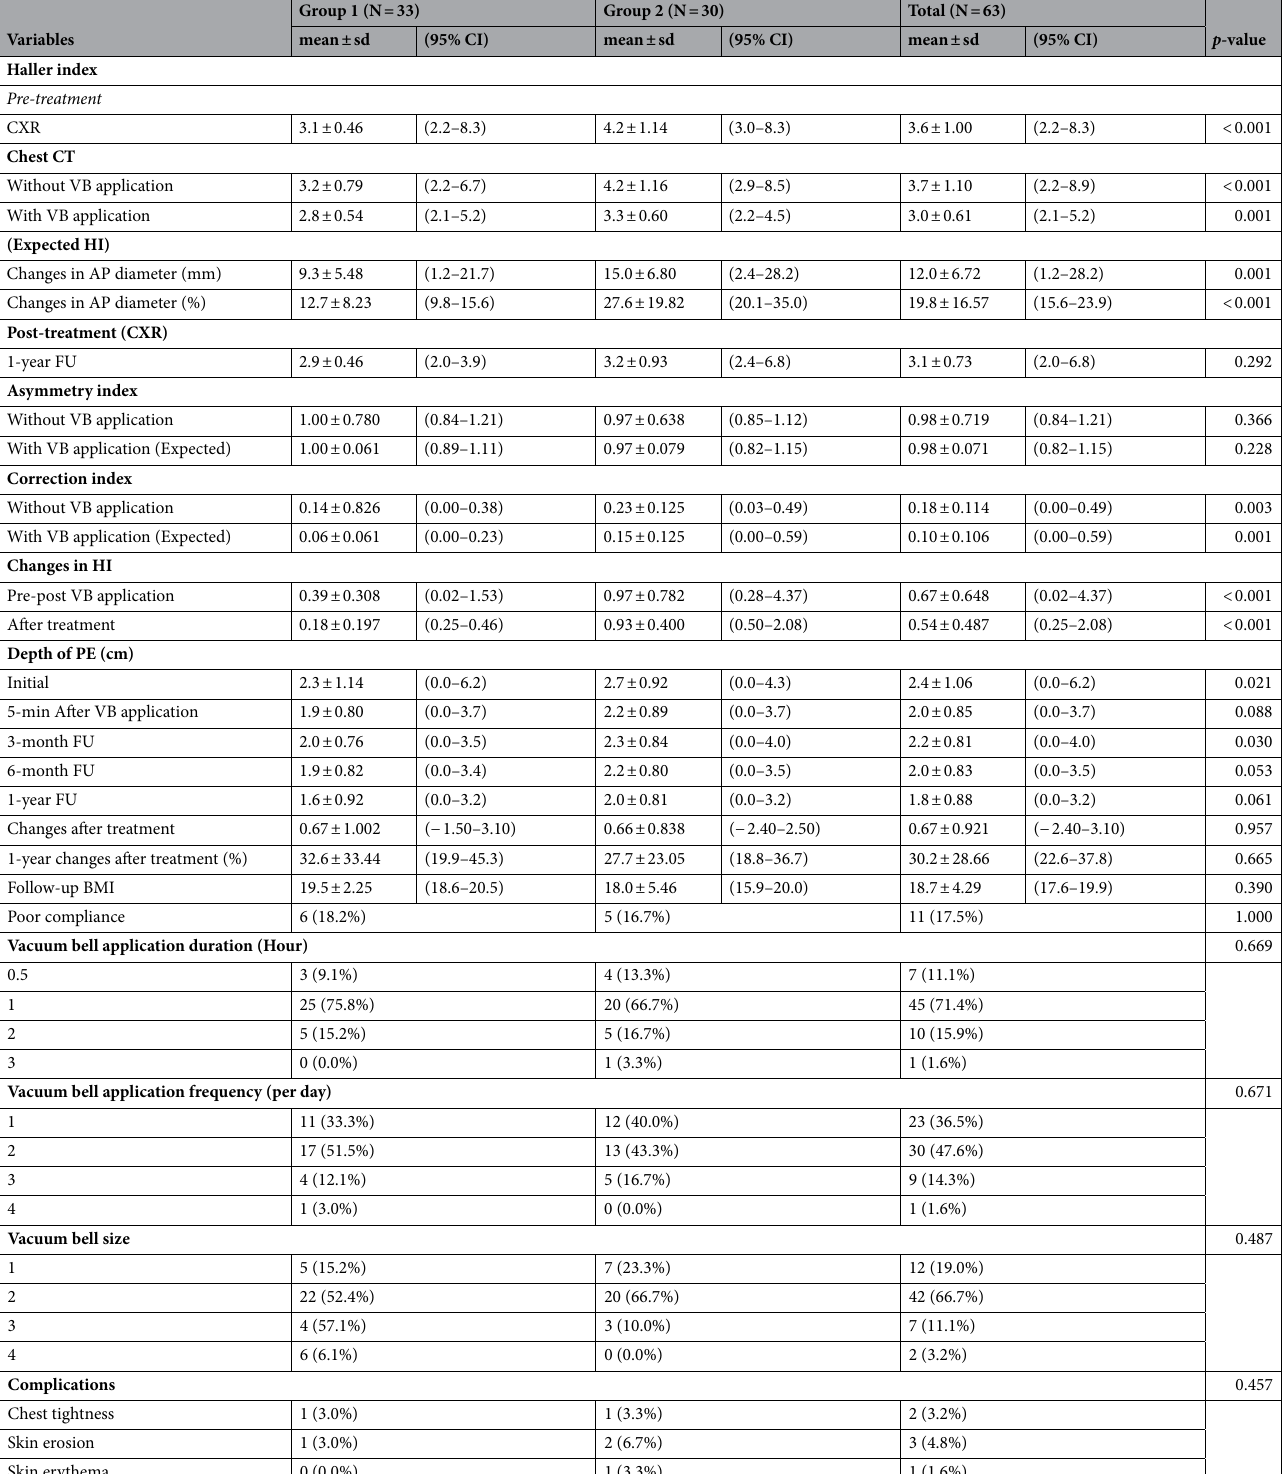
Table 2. Thoracic indices before and after vacuum bell therapy. Haller indices were calculated both from pretreatment imaging modality including pretreatment chest CT or chest X-ray as well as chest X-ray after 1-year treatment. Asymmetry and Correction indices were measured only from pretreatment chest CT scans. Expected indices were estimated under VB application in chest CT and could imply possible changes when the treatment would proceed. CT computed tomography, CXR chest radiography, FU follow-up, HI Haller index, PE pectus excavatum, sd standard